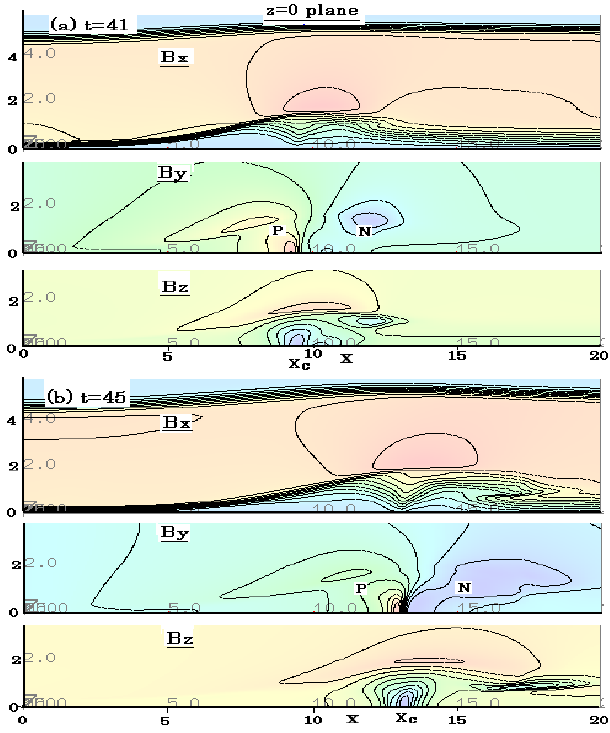
Fig. 8. Distributions of magnetic field components B x ,B y and B z in the z = 0 plane at times t = 41 and 45 with the contour interval (Color online) Distributions of magnetic fleld of 0 . 1, where the locations of the plasmoid center X C is indicated, components B x ; B y and B z in the z = 0 plane at times t = 41 and P and N in B y indicate, respectively, the positive value (the and 45 with the contour interval of 0 : 1, where the locations reconnected field lines) and negative value (the sheared field lines initially embedded in the current sheet) ( B z 0 =− 0 . 1 and α =− 0 . 1). of the plasmoid center X C is indicated, and P and N in B y indicate, respectively, the positive value (the reconnected fleld lines) and negative value (the sheared fleld lines initially embedded in the current sheet) ( B z 0 =